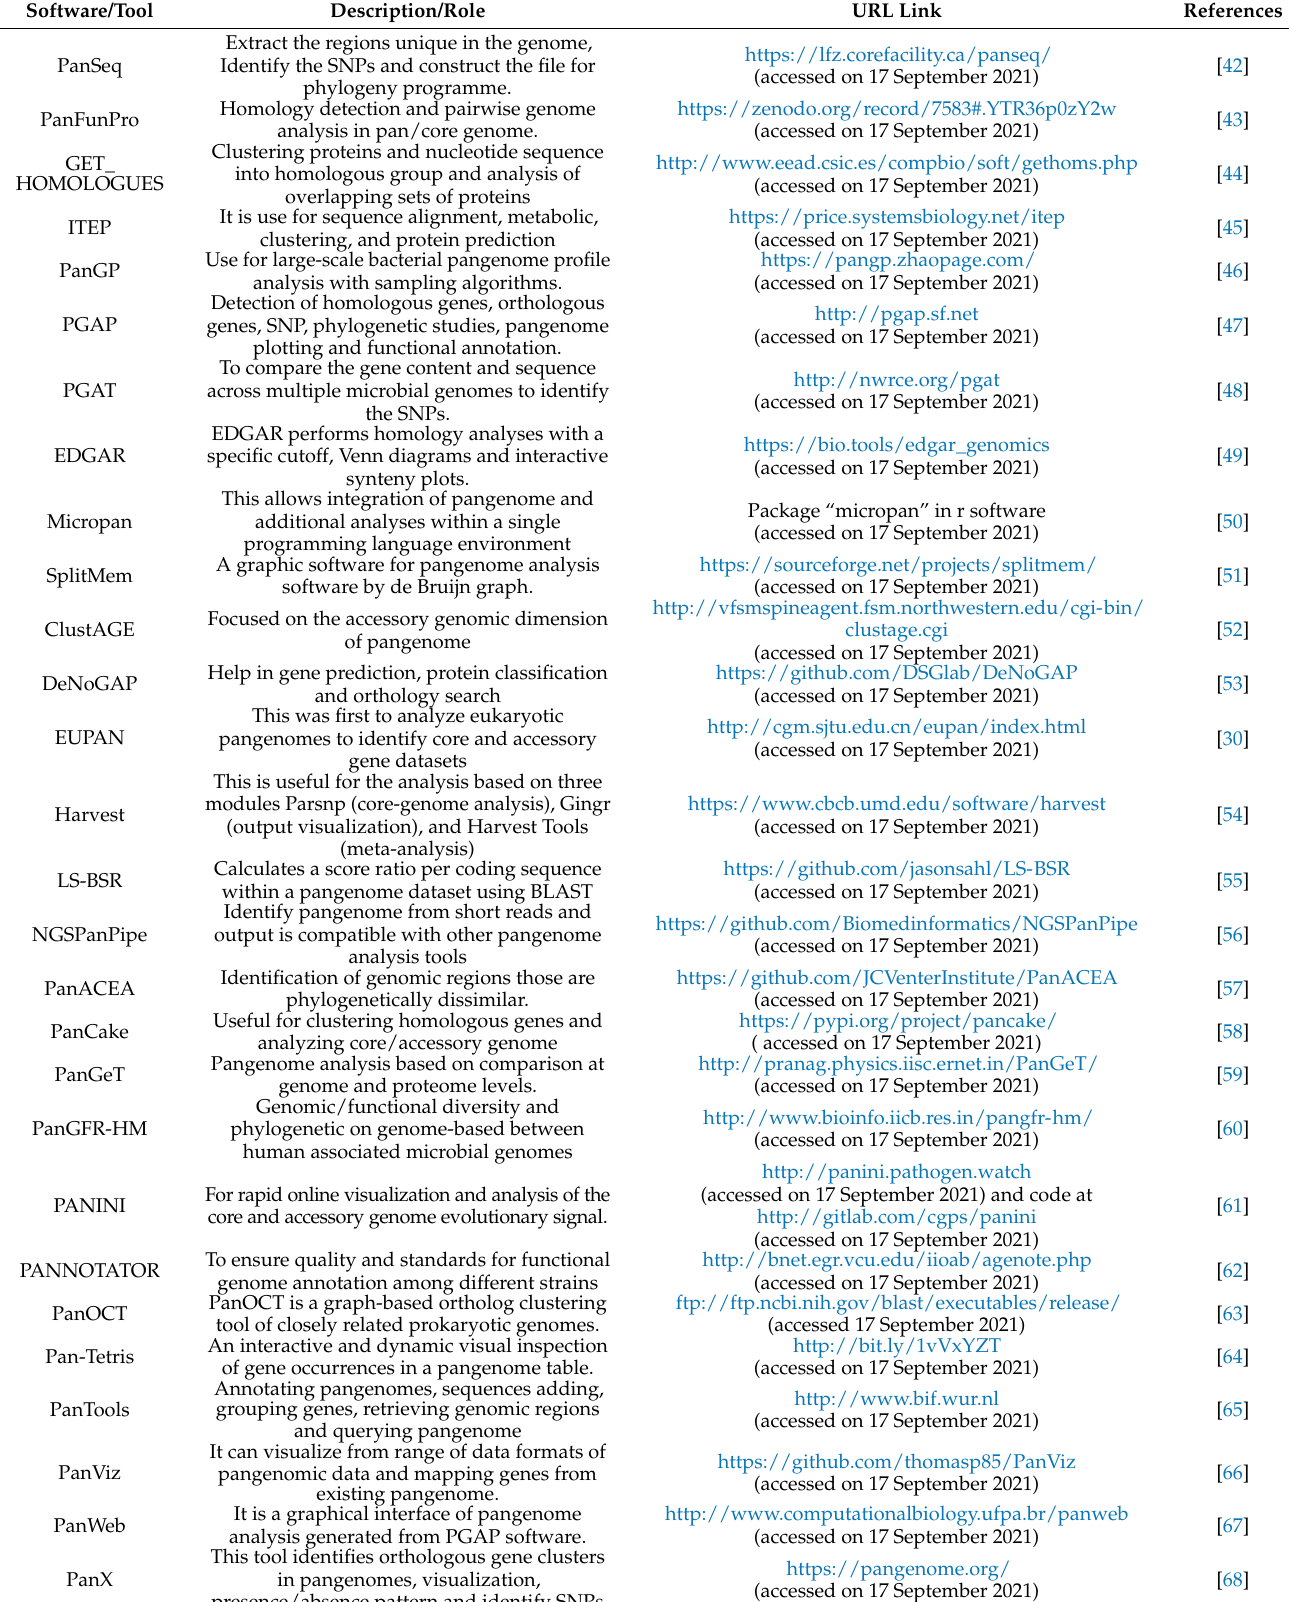
Table 1. Software/tools for pangenome